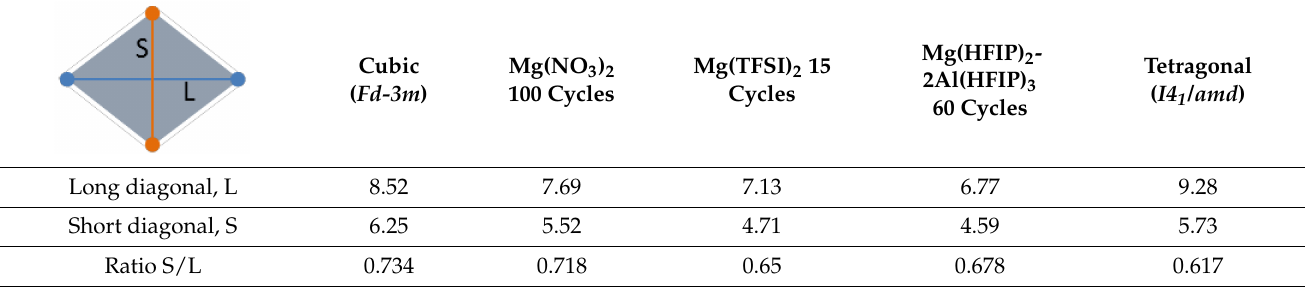
Table 2. Measured short (S) and long (L) diagonal distances in the Mn diamond viewed in <010> tetragonal and in <110> cubic zone axis and their calculated S/L ratio for cubic MgMn 2 O 4 , tetragonal MgMn 2 O 4 , and all three samples cycled in different electrolytes. Values for diagonal lengths are given in Å. The error of experimental length determination was in the range pixel size of ± 0.08